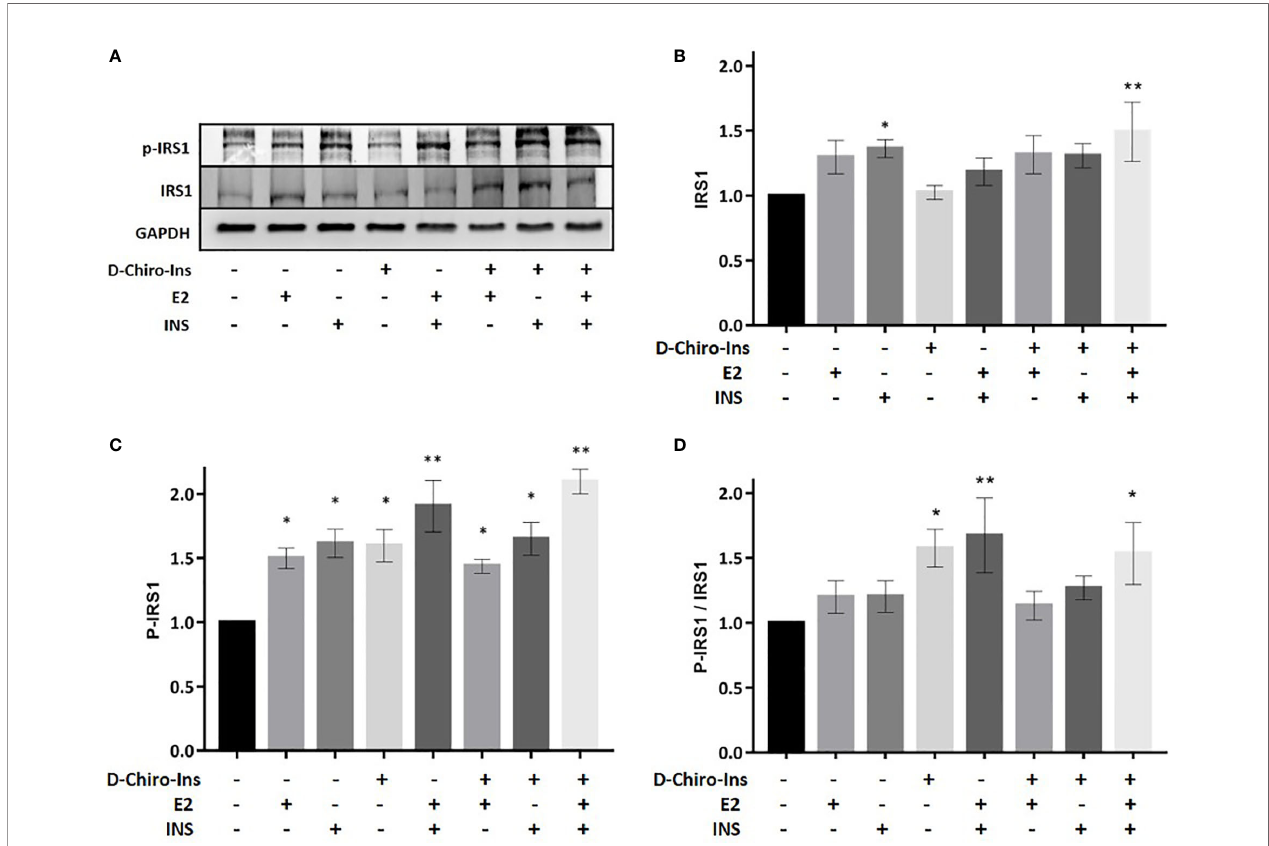
FIGURE 5 | D-Chiro-Ins modulates the expression and phosphorylation of IRS1 in mature adipocyte. Mature SGBS adipocytes cells were treated with D-Chiro-Ins 10 − 8 M, E2 10 − 9 M or INS 10 − 7 M, and combinations for 24 ho. Cell lysates were immunoblotted with an anti-IRS1 antibody, anti-p-IRS1 antibody, and anti-GAPDH antibody. (A) Panels show representative blot of IRS1, p-IRS1 Tyr941 and GAPDH. The expression level of IRS1 and p-IRS1 was normalized with the protein amount of GAPDH, relative to the control. In the p-IRS1 Tyr 941 blot the band subjected to quanti fi cation is the lower, corresponding to 170 kDa. (B – D) Analysis of the relative expression level of IRS1, p-IRS1 and the ratio p-IRS1/IRS1. Values are presented as mean ± SEM of three independent experiments. Results were analyzed statistically by one-way RM ANOVA followed by Dunnett ’ s multiple comparisons test (*p < 0.05, **p < 0.01 versus control). D-Chiro-Ins, D-chiro-Inositol; E2, 17 b -estradiol, INS, insulin; IRS1, insulin receptor substrate 1; p-IRS1, phospho-IRS1; GAPDH, glyceraldehyde-3-phosphate